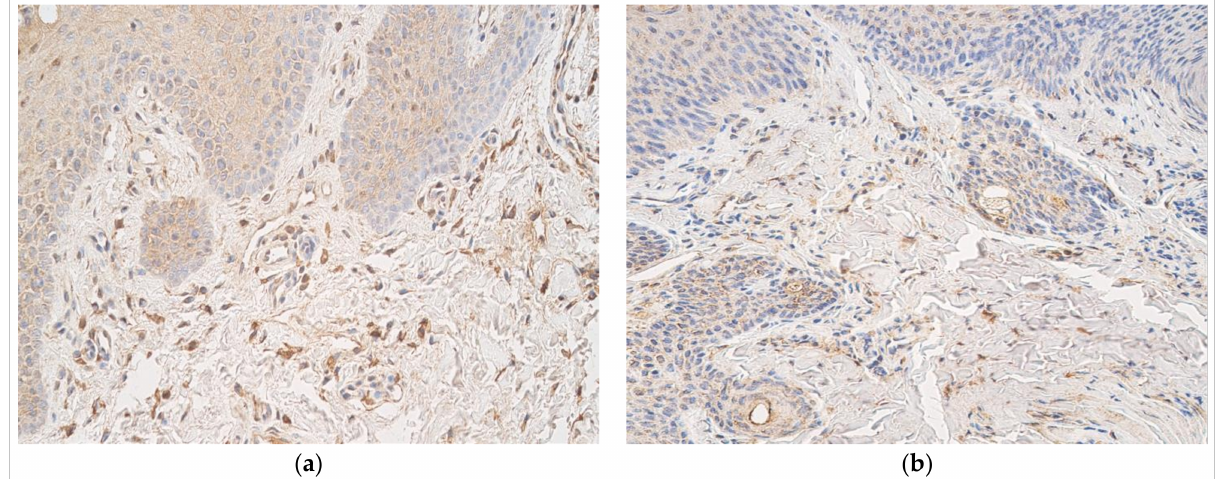
Figure 4. Immunohistochemical micrographs of M2 in a cleft affected lip tissue and in a control subject. ( a ) Moderate M2 cells (++) in the connective tissue of the cleft lip tissue sample in an eight months old child with a cleft lip and palate. M2 IMH, x250; ( b ) Occasional positive M2 cells (0/+) in the control group tissue sample of a six years old child. M2 IMH, ×